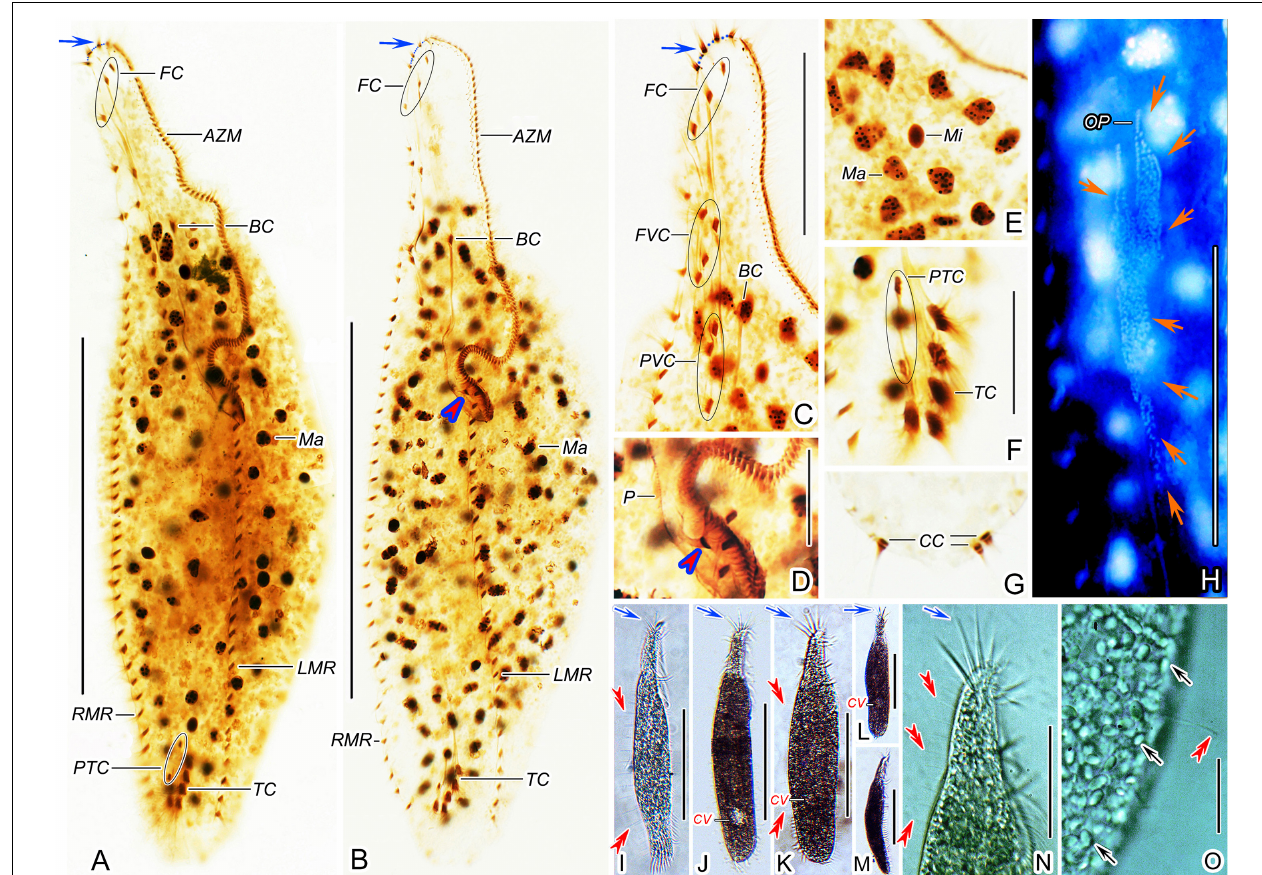
FIGURE 2 | Trachelostyla multinucleata spec. nov. after protargol impregnation (A–H) and from life (I–O) . (A,B) Ventral views of holotype (A) and a paratype specimen (B) , showing the ciliary pattern and the nuclear apparatus. Blue arrows show the four enlarged adoral membranelles and red arrowhead indicates the extra cirrus above the buccal vertex. (C,D) Ventral views of the oral region. Blue arrow shows the four enlarged adoral membranelles and red arrowhead indicates the extra cirrus. (E) Macronuclear nodules and micronuclei. (F,G) Ventral (F) and dorsal (G) views of the posterior body region, showing prentransverse ventral and transverse cirri as well as caudal cirri. (H) Ventral view of an early divider, showing the opisthe’s oral primordium (red arrows). (I–M) Ventral (I–L) and lateral (M) overviews of different specimens, showing different body shapes, dorsal bristles (red double-arrowheads) and enlarged adoral membranelles (blue arrows). (N) Ventral view of the anterior body region, blue arrow shows the four enlarged adoral membranelles and red double-arrowheads mark dorsal bristles. (O) Dorsal view, showing endoplasmic granules (black arrows) and a dorsal bristle (red double-arrowhead). AZM, adoral zone of membranelles; BC, buccal cirrus; CC, caudal